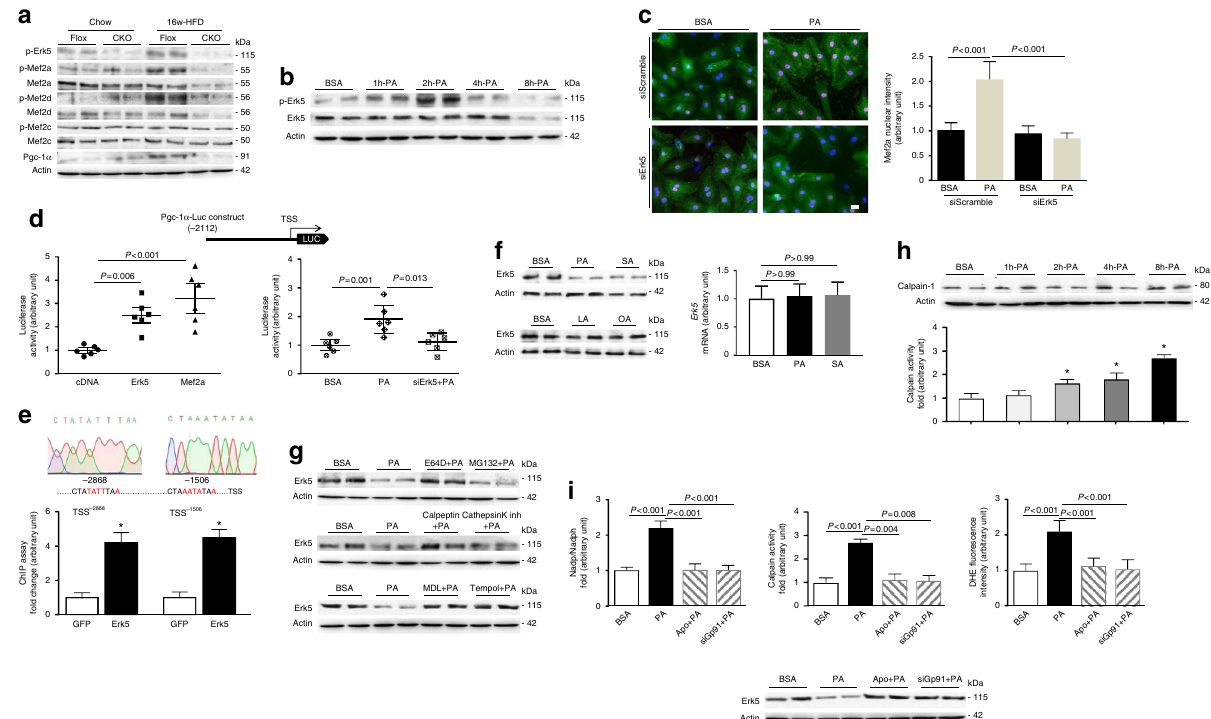
Fig. 6 Molecular basis underlying Erk5 regulation of Pgc-1 α and Erk5 degradation. a Immunoblot analyses revealed the phosphorylation level and total expression of Erk5, Mef2a, Mef2c, Mef2d, and Pgc-1 α in the hearts of Flox and CKO mice fed with chow or HFD for 16 weeks. b Immunoblot analyses showed increased activation of Erk5 in NRCMs treated with palmitate acid (PA, 500 µ M) for 2 h; while the total expression of Erk5 is signi fi cantly decreased by PA for 8 h. c NRCMs were stained with DAPI ( blue ), anti- α -actinin antibody ( green ), and Mef2a ( red ) ( scale bar : 20 μ m), fl uorescence intensity of Mef2a in nuclei was quanti fi ed. d Increased Pgc-1 α reporter luciferase activity was detected with overexpression of Erk5 or MEef2a. The increased reporter activity induced by palmitate was blunted by knockdown of Erk5 in NRCMs. e ChIP analysis demonstrated that enhanced binding of Mef2a to the Ppargca (Pgc-1 α ) promoter region at two sites (TSS, transcriptional starting site, -1506 and -2868, marked in red ) in HL-1 cardiomyocytes is Erk5-dependent. Sequence analysis of the puri fi ed PCR fragment bound by anti-Mef2a antibody con fi rmed the Mef2 consensus binding sequence. f Immunoblot analyses showed decreased Erk5 in ARCMs treated with 8 h PA or stearate acid (SA, 500 µ M), but not by unsaturated FFA linoleate acid (LA, 500 µ M) or oleate acid (OA, 500 µ M). qPCR analysis showed no reduction in mRNA expression of Erk5 in PA or SA-treated ARCMs. g Immunoblot analyses showed that degradation of Erk5 was blocked by pretreatment of E-64D (25 μ M, 4 h), but not by MG132 (10 μ M, 4 h). Erk5 degradation was caused by calpain-1 and its expression could be restored by calpeptin (20 μ M, 6 h), MDL-28170 (30 μ M, 16 h) or Tempol (10 nM, 16 h), but not